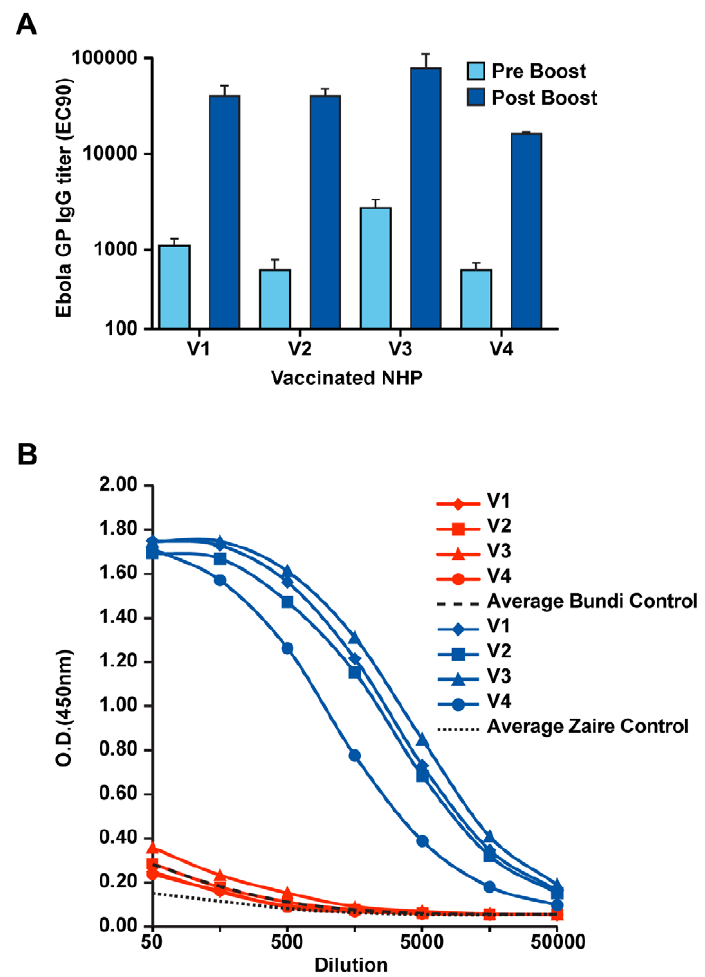
Figure 2. Development of vaccine-induced antibody responses. (A) The quantity of anti-Ebola GP IgG in plasma samples from vaccinated cynomolgus macaques was determined by ELISA as described in Methods. Results are shown for samples obtained after the final DNA prime and prior to immunization with rAd (pre-boost, light blue), and for samples obtained 3 weeks after boosting with rAd-GP (post-boost, dark blue). Plasma antibody titers are presented as EC90 reciprocal dilution titers. (B) ELISA IgG against ZEBOV (blue) and BEBOV (red) antigens. Plasma dilution series are shown for each immunized subject. The averages for negative control samples (n=4) are shown for ZEBOV (black dotted line) and BEBOV (black dashed line).